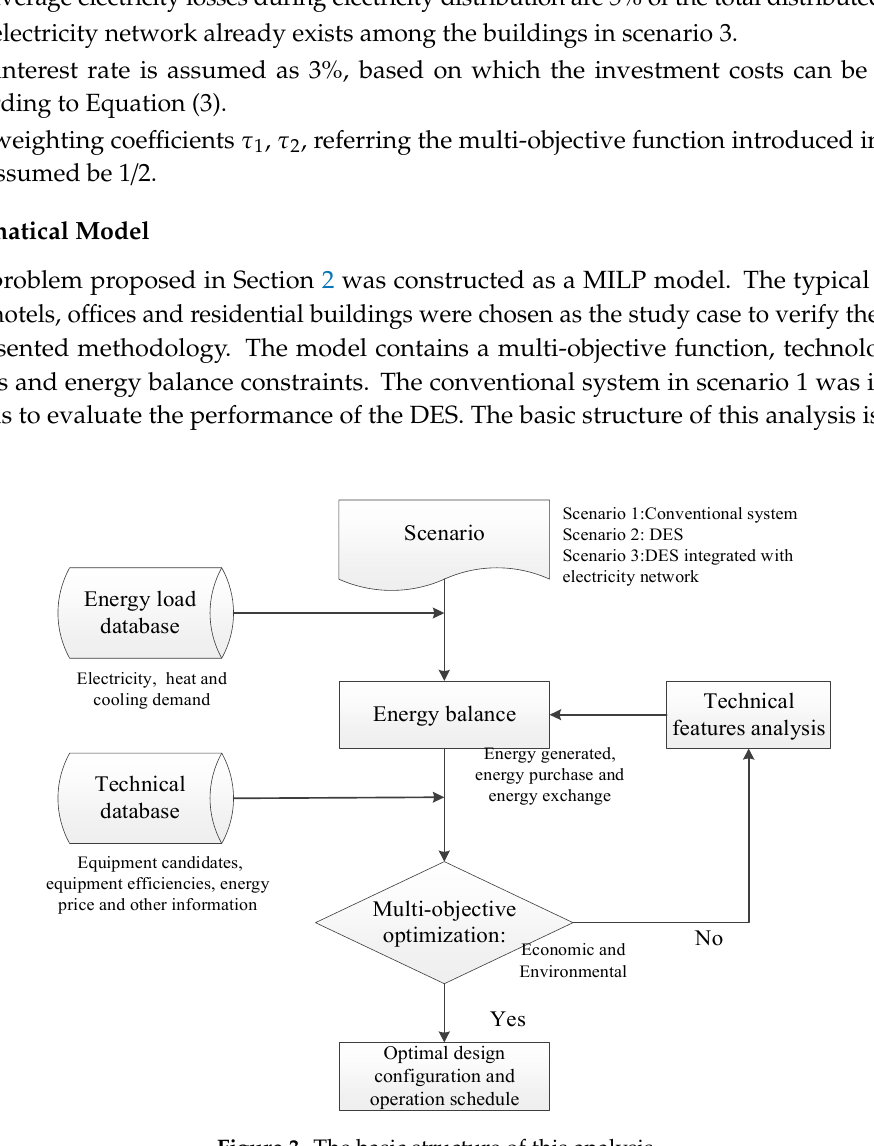
Figure 3. The basic structure of this analysis.